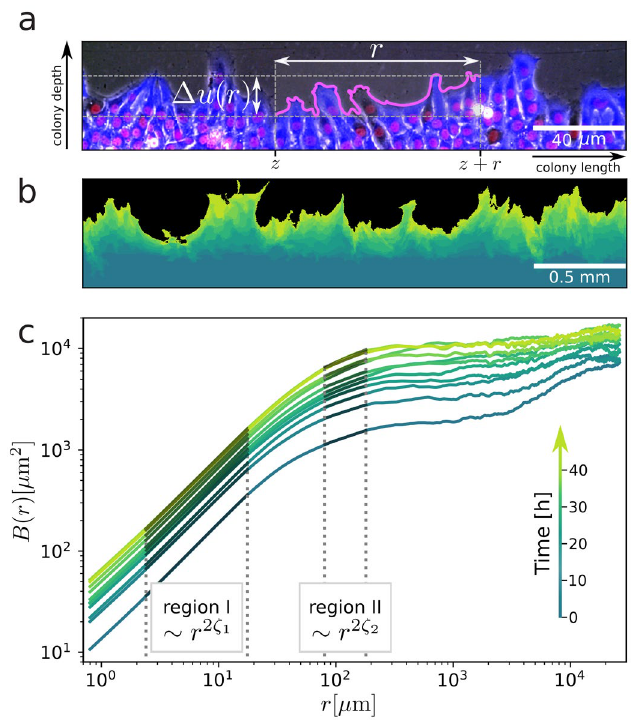
Figure 1. Proliferating Rat1 fibroblast cell front under control conditions. ( a ) Optical phase microscopy image of a section of the cell front, overlaid with cytoplasm (blue) and nuclei (red) fluorescence. The relative displacements � u ( r . z ) = u ( z ) − u ( z + r ) are measured between pairs of points separated by a distance r , and their correlations give a quantitative assessment of the cell front roughness. ( b ) Superposition of successive fluorescence microscopy images taken over 40 h. ( c ) Average cell front roughness B ( r ) = (cid:31) | � u ( r . z ) | 2 (cid:30) ∼ r 2 ζ showing two distinct regions of power law scaling. In ( b ) and ( c ) the same time scale of dark to light green is